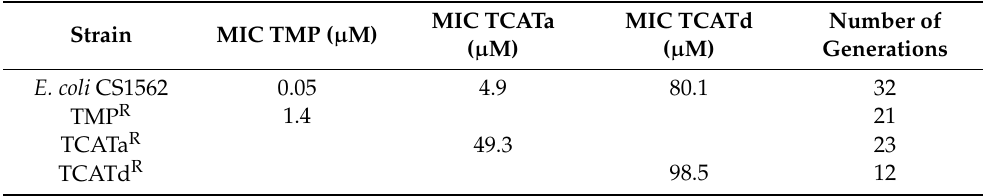
Table 1. Minimal inhibitory concentration for TMP, TCATa and TCATd of the E. coli parent strain and resistant isolates. As well as the number of generations grown during the experiment. Resistant isolates from each condition are characterized by a superscript R ( R